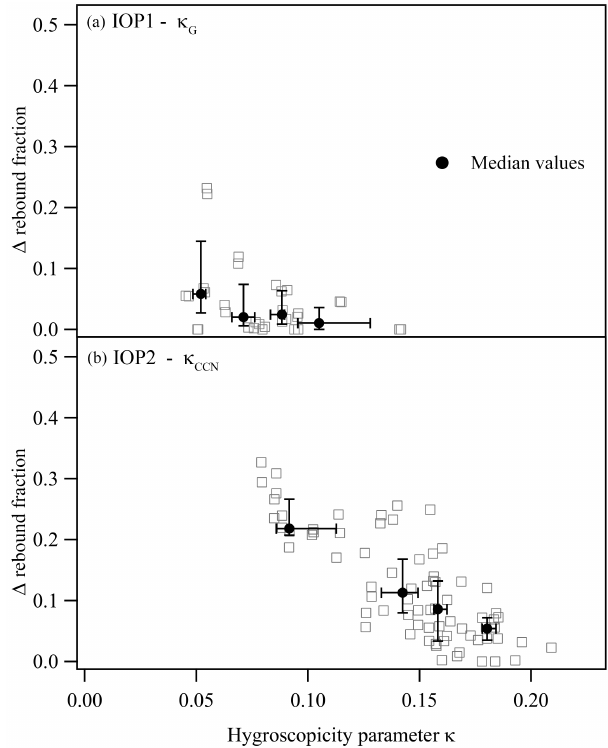
Figure 7. Scatter plot of rebound deviation with the hygroscopic- ity parameter κ for (a) IOP1 and (b) IOP2. For clarity of presen- tation, data points are shown for apparatus RH values between 73 and 78%, although the trend applies more broadly. As a guide to the eye, in each panel data are divided into four groups, and me- dians and quartiles of the groups are plotted as black circles and whiskers, respectively. Different techniques were used to measure κ G and κ CCN , as described in the main